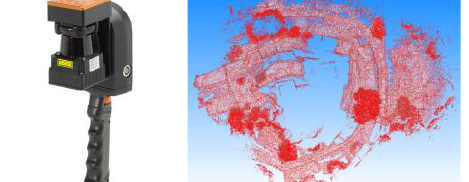
Figure 11. The Zeb Revo by GeoSlam (left) and a plan view othe the dataset acquired on the Rocca